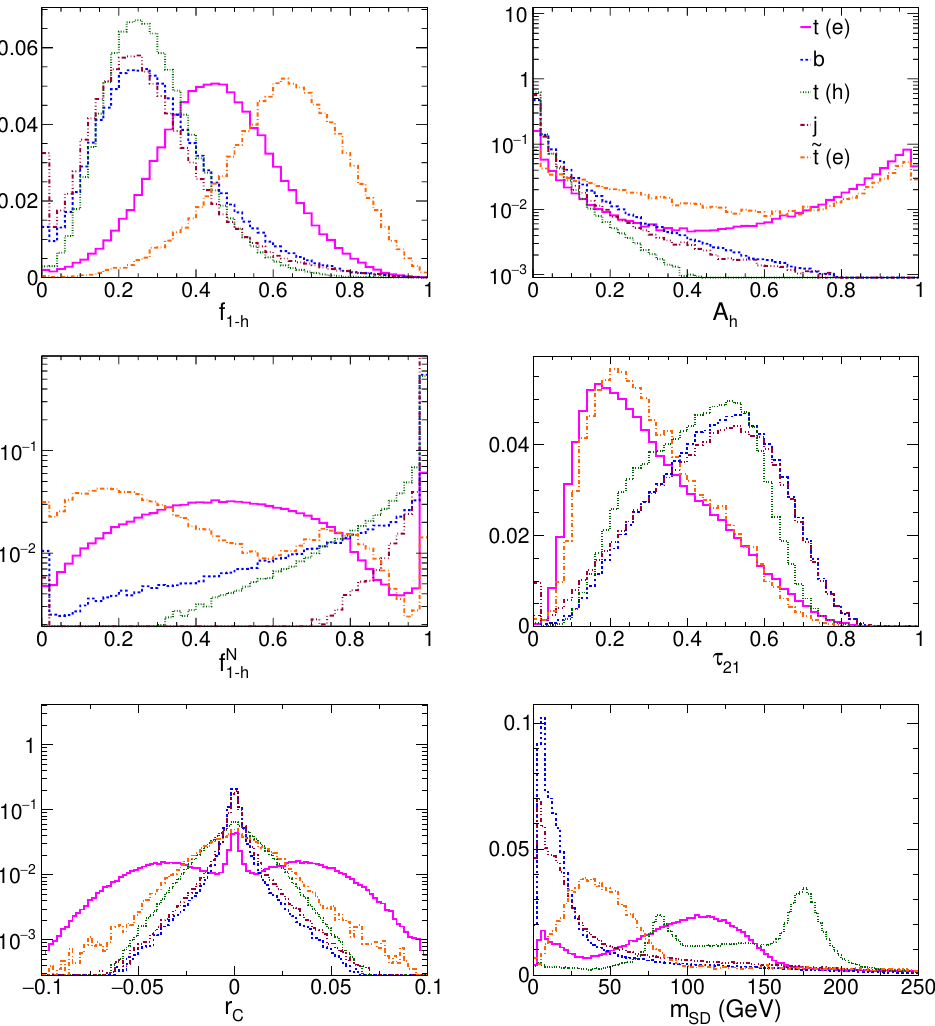
Figure 2 . Distribution of f 1-h (top left), A h (top right), f N (bottom left), and m SD (bottom right) of the jet for di(cid:11)erent event samples